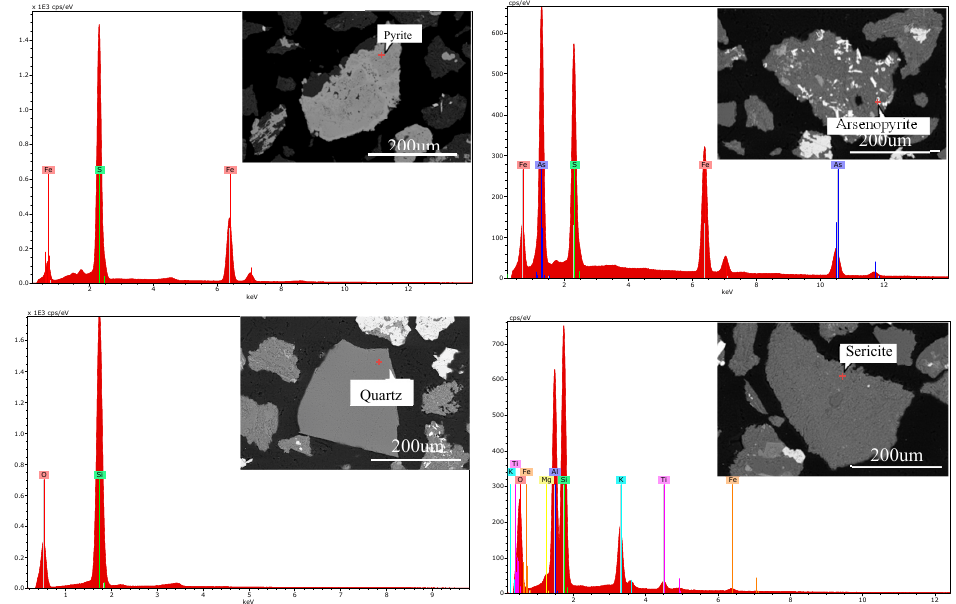
Figure 1. The SEM-EDS images of arsenious and sulfur-bearing Carlin-Type gold ore.